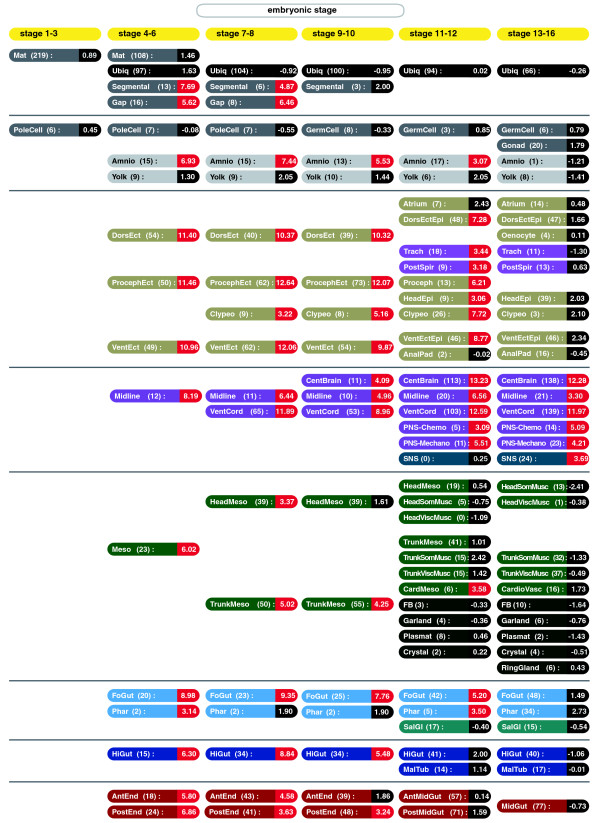
Spatio-temporal over-representation of transcription factors in embryonic development. This figure uses the slim representation of the anatomical ontology from Tomancak et al. [30] with the same color codes. The number of TFs expressed at the given spatio-temporal coordinate is provided in brackets, and the decimal number indicates the Z score for the over-representation of TFs in comparison to non-TFs. Statistically significant enrichment of TFs versus non-TFs (Z > 3) is highlighted in red.